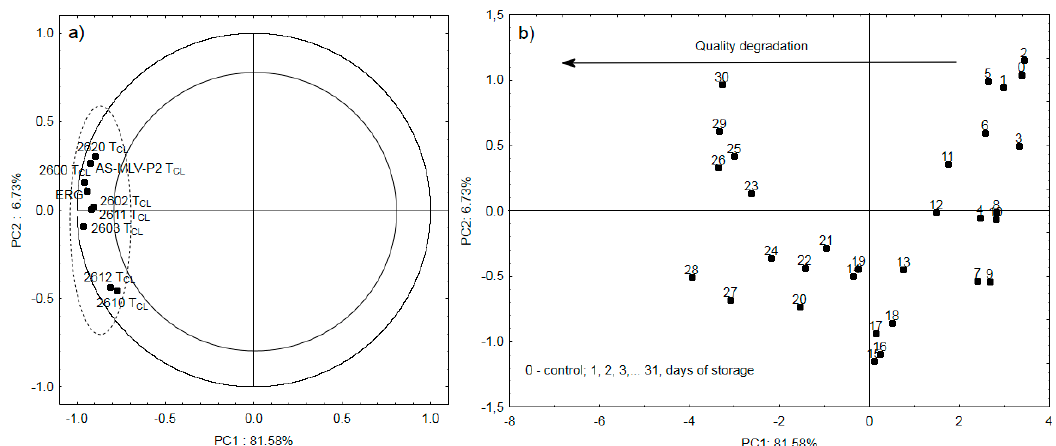
Figure 6. ( a ) location of loading vectors relative to the first two principal components (PC1, PC2) from eight sensor readings for T CL and ergosterol obtained for 31 days of storage; ( b ) plot of two principal component scores (PC1, PC2) from eight sensors for T CL readings and ergosterol obtained for 31 days of storage.